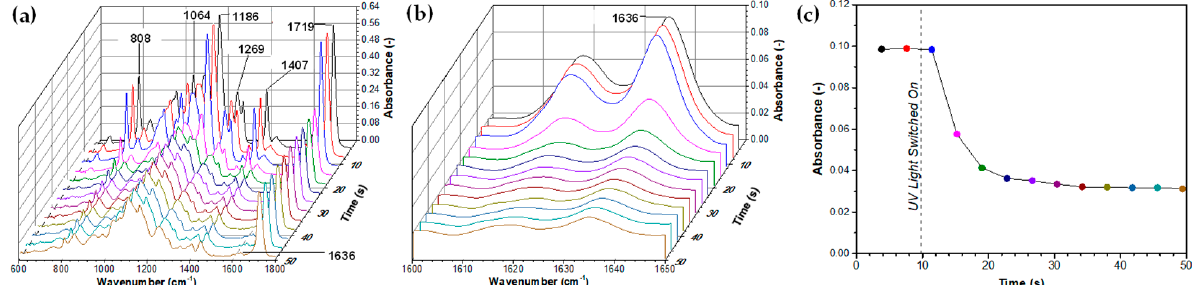
Figure 10. Real-time ATR-FTIR absorption spectra for UV-crosslinking of pure PEGDA in the presence of 1 wt% photo-initiator. The wavenumber regions are: ( a ) 600–1800 cm − 1 ; ( b ) 1600–1650 cm − 1 . The disappearance of the peak at 1636 cm − 1 with time due to the conversion of C=C bonds to C-C is shown in ( c ). The interval between spectra iterations was 3.8 s.